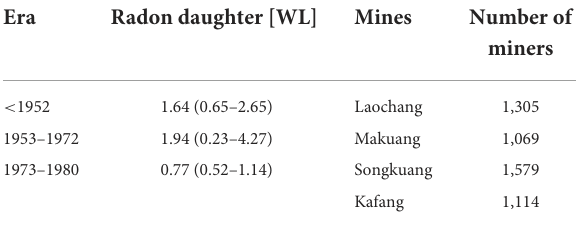
TABLE 1 Calculated or measured mean values of Arsenic Concentration by era.